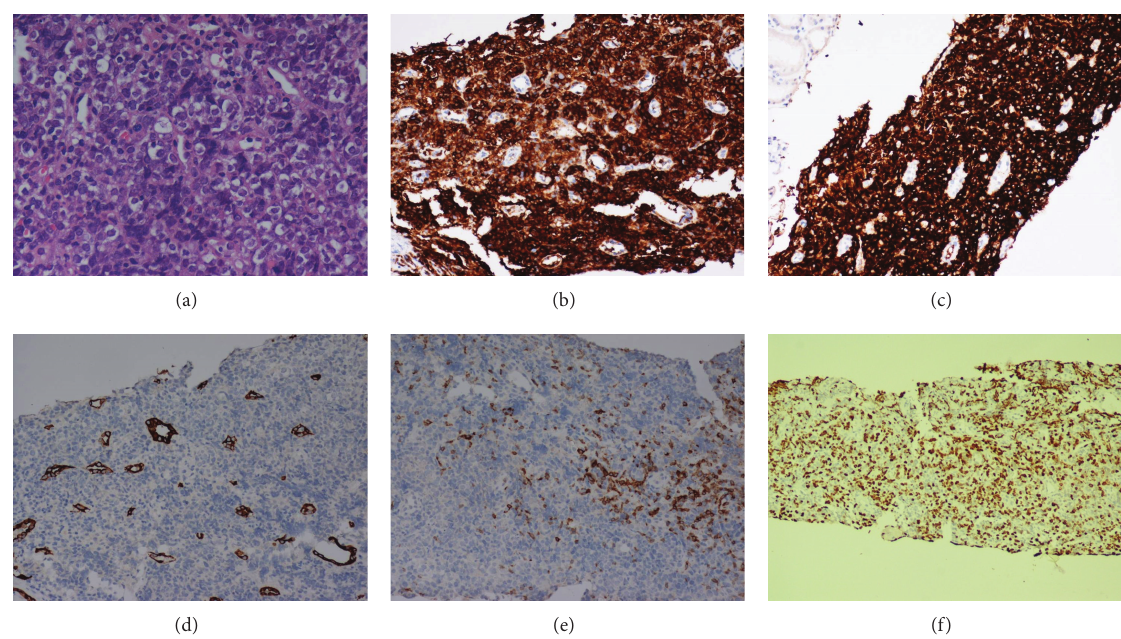
Figure 3: Renal pathology. Renal cortex replaced by medium-sized to large atypical lymphoid cells. The tumor cells show high nucleocytoplasmic ratio, prominent eosinophilic nucleoli, and single cell apoptosis in haemotoxylin eosin stain × 100 (a). The tumor cells are positive for LCA × 100 (b), CD20 × 100 (c), but negative for CK × 100 (d), CD3 × 100 (e), and Ki-67 stain × 100 (f) shows the positivity focally up to 60%.